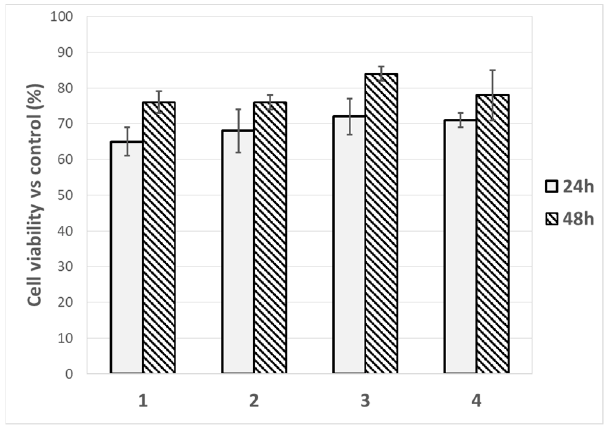
Figure 8. Cell viability of compounds 1 , 2 , 3 and 4 treated with HaCaT cells at 24 h and 48 h.